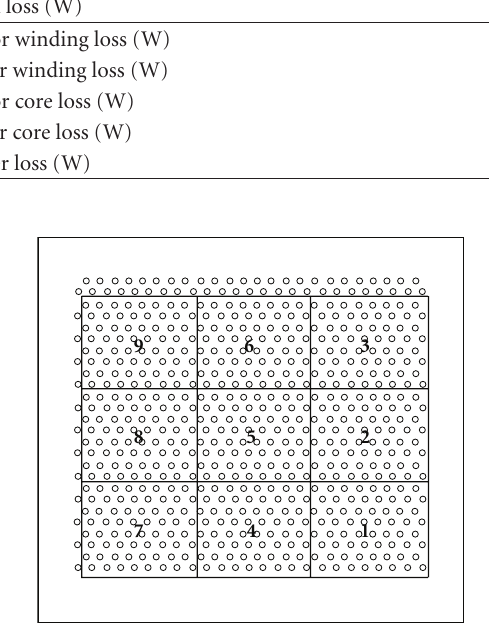
Figure 5: Block numbers for the external air in heat exchanger.